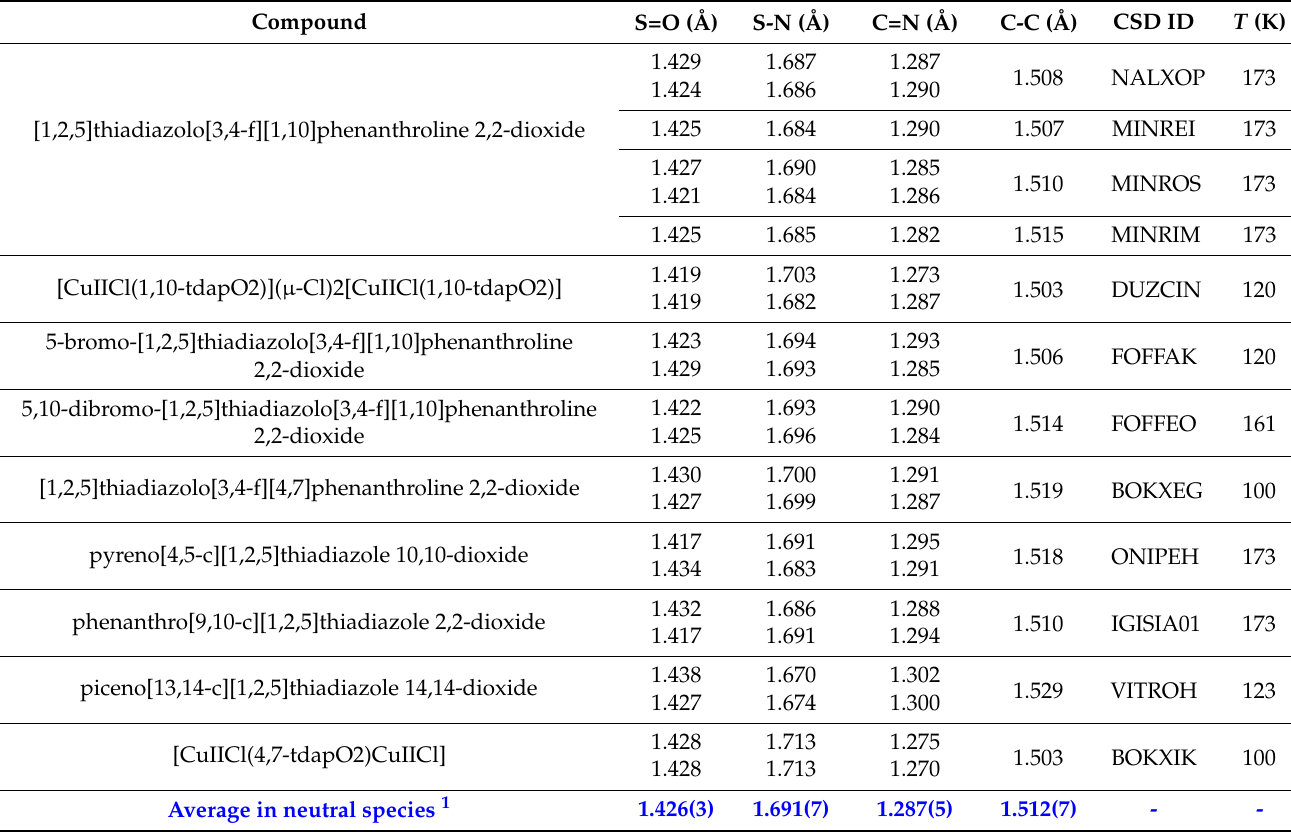
Table 2. Selected bond lengths for neutral and anionic dioxothiadiazoles (structures collected at 100–173 K). The average values given in blue and red correspond to the blue and red bars in Figure